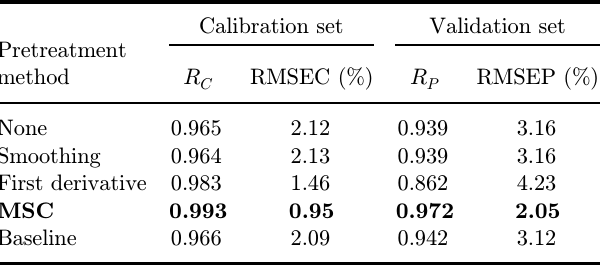
Table 1. Performance comparison results for chlorpyrifos residue developed by PLS with di®erent preprocessing methods.